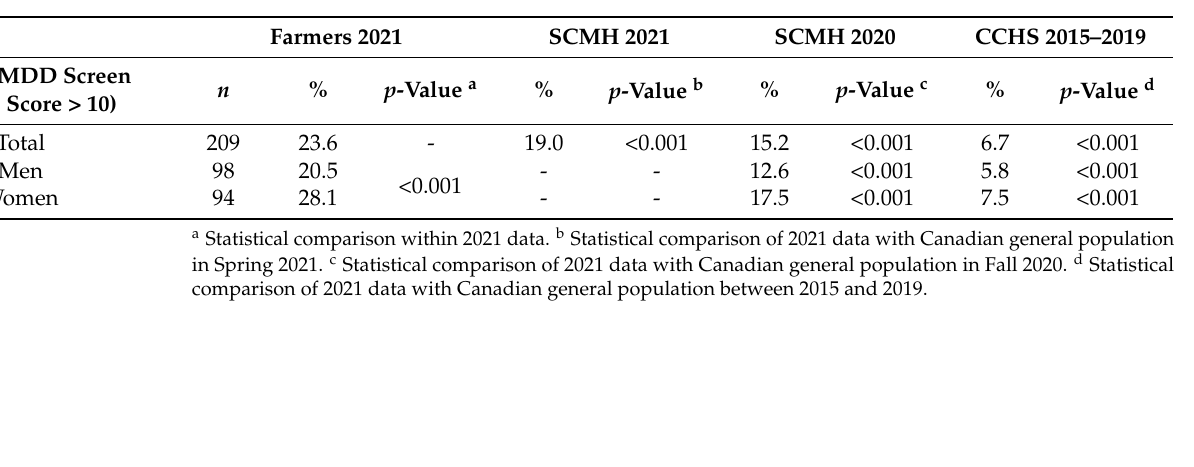
Table 5. Prevalence of positive MDD screen (PHQ-9 score >10) for the overall 2021 sample and by gender, and in comparison to Canadian general population from Statistics Canada’s Survey of COVID-19 and Mental Health (SCMH) cycles 1 (Spring 2020) and 2 (Fall 2021) and prior to the pandemic from Canadian Community Health Survey (CCHS) data (2015–2019) [57].